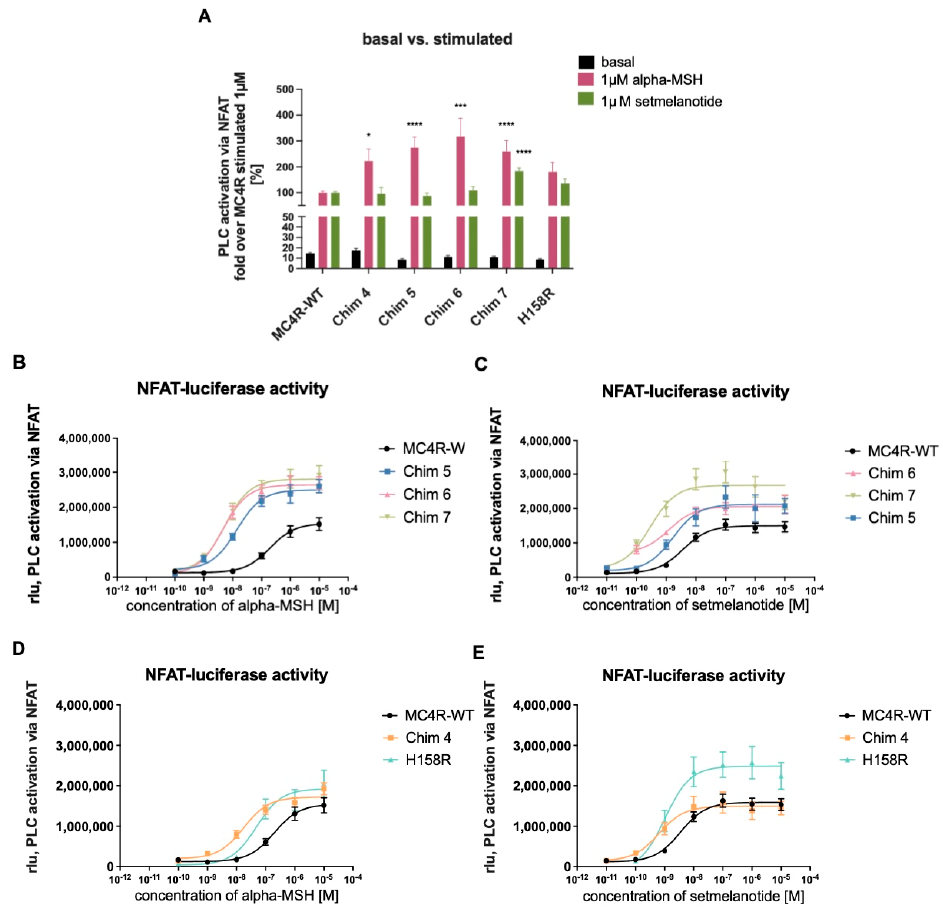
Figure 4. G q/11 signaling of chimeric receptors and the H158R mutation compared to MC4R-WT. NFAT-reporter gene assay quantifying relative light units (rlu) to determine G q/11 signaling capacities. HEK 293 cells were transfected with MC4R-WT, chimeric receptors, or H158R mutation. ( A ) Basal activity and 1 µ M stimulated values of chimeric receptors and the H158R mutation compared to MC4R-WT. Basal activity of chimeric receptors is very similar to MC4R-WT. Chim 4, Chim 5, Chim 6, and Chim 7 displayed significant alpha-MSH induced increase in G q/11 activity compared to alpha-MSH stimulated MC4R-WT. Values represent fold over 1µM stimulated MC4R-WT. For statistical analysis, a one-way ANOVA with Kruskal–Wallis test was performed, comparing MC4R-WT to chimeric receptors and the H158R mutation. Values represent mean ± SEM. Statistical significance is indicated by * p < 0.05, *** p < 0.001, and **** p < 0.0001. Concentration response curves of Chim5, Chim 6, and Chim 7 cells were stimulated with different concentrations of ( B ) alpha-MSH or ( C ) setmelanotide. Concentration response curves of Chim 4 and H158R mutation were stimulated with different concentrations of ( D ) alpha-MSH or ( E ) setmelanotide. Data are given as raw rlu. Data represent WT (alphaMSH n = 10, setmelanotide n = 17), H158R (n = 4), Chim 4 (alpha-MSH n = 5, setmelanotide n = 7), Chim 5 (n = 4), Chim 6 (alpha-MSH n = 4, setmelanotide n = 3), and Chim 7 (alpha-MSH n = 9, setmelanotide = 10) experiments, each performed in triplicate. Values represent mean ± SEM. E max and EC 50 values are summarized in Table 1. Efficacy (E max ), potency (EC 50 ), and bias of ligand stimulated MC4R-WT, chimeric recep- tors, and H158R. Concentration–response curves were used to determine potency under alpha-